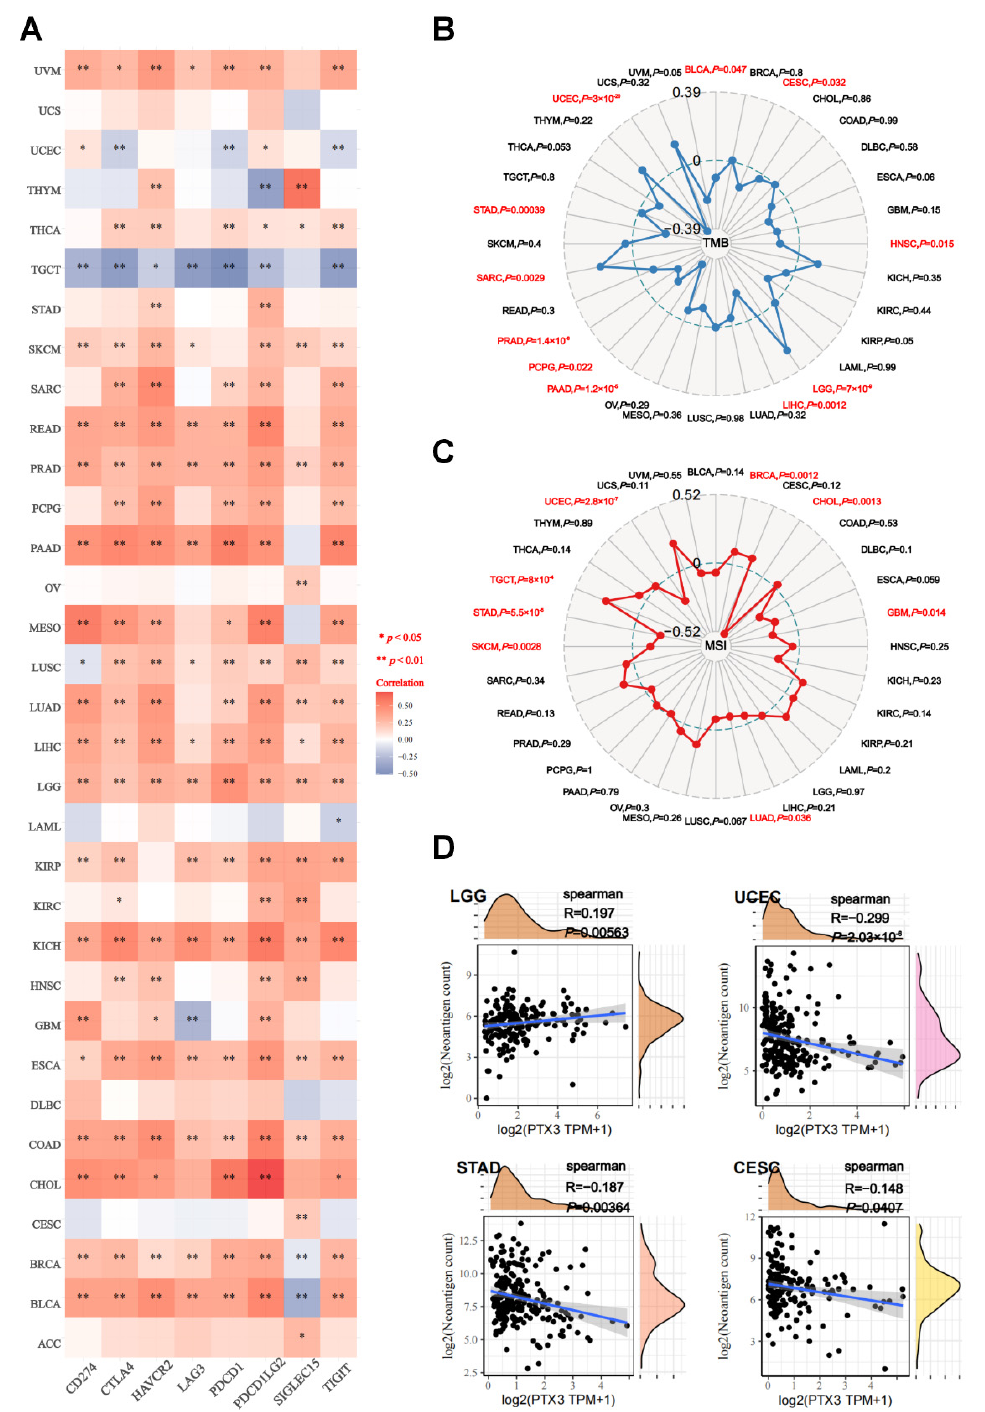
Figure 9. Correlation between PTX3 and immunotherapy: ( A ) Correlation of PTX3 with ICI; ( B ) radar map illustrating the relationship between PTX3 expression with TMB (red color indicated statistical significance and the red lines represent correlation coefficients); ( C ) radar map illustrating the relationship between PTX3 expression with MSI (red color indicated statistical significance and the blue lines represent correlation coefficients); ( D ) correlation of PTX3 with NEO. (Spearman correlation test, * p < 0.05 and ** p < 0.01).